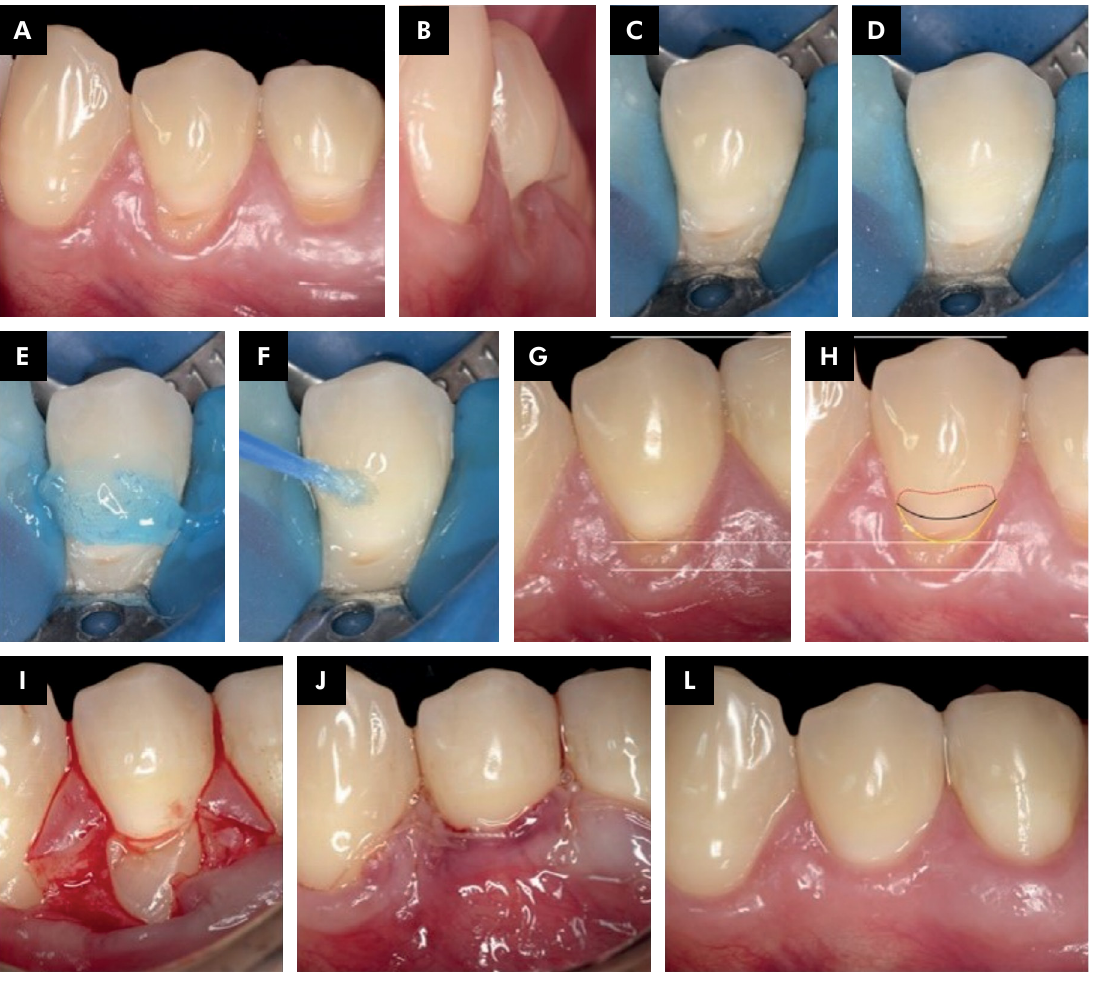
Figure 5. Representative case of a combined defect (CD) treated with a partial restoration (CEJ+1 mm) of the non-carious cervical lesion (NCCL) and a coronally advanced flap with connective tissue graft (a-i); Facial (a) and lateral (b) views of the recession type 1 and B+ NCCL. Rubber dam placed (c). Bevel performed to reduce the coronal border of the NCCL and provide a proper and harmonious emergence profile (d). Restorative procedures (e, f). After completion of the restorative procedure. The apical margin of the restoration was placed 1 mm apical to the estimated cementoenamel junction (CEJ) level (CEJ+1 mm) (g). The red line represents the coronal border of the NCCL, the black scalloped line represents the location of the lost CEJ level, estimated by one of the available methods, and the yellow scalloped line represents the level where the apical margin of the restoration should be (h). After flap preparation, the apical border of the NCCL was planed and the graft was stabilized (i). The flap was coronally sutured (j). One year postoperatively